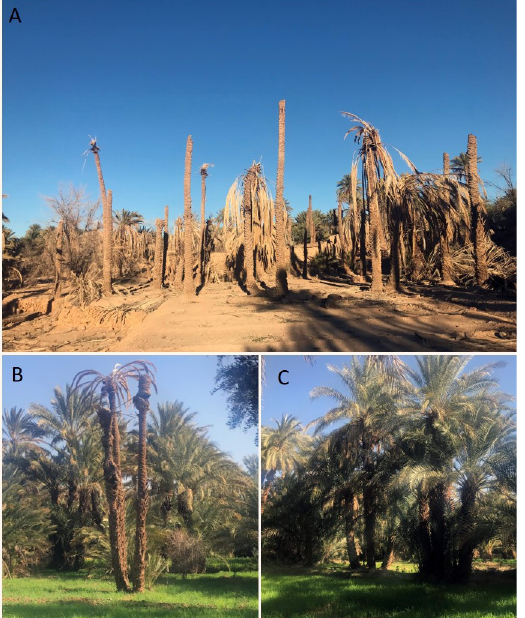
Fig 1. Dieback of date palm in a natural oasis in Morocco. (a) Palm dieback disease taking a pandemic scale and leading to ecological collapse of a Moroccan oasis. (b) Date palm tree showing dieback on the crown. (c) Healthy date